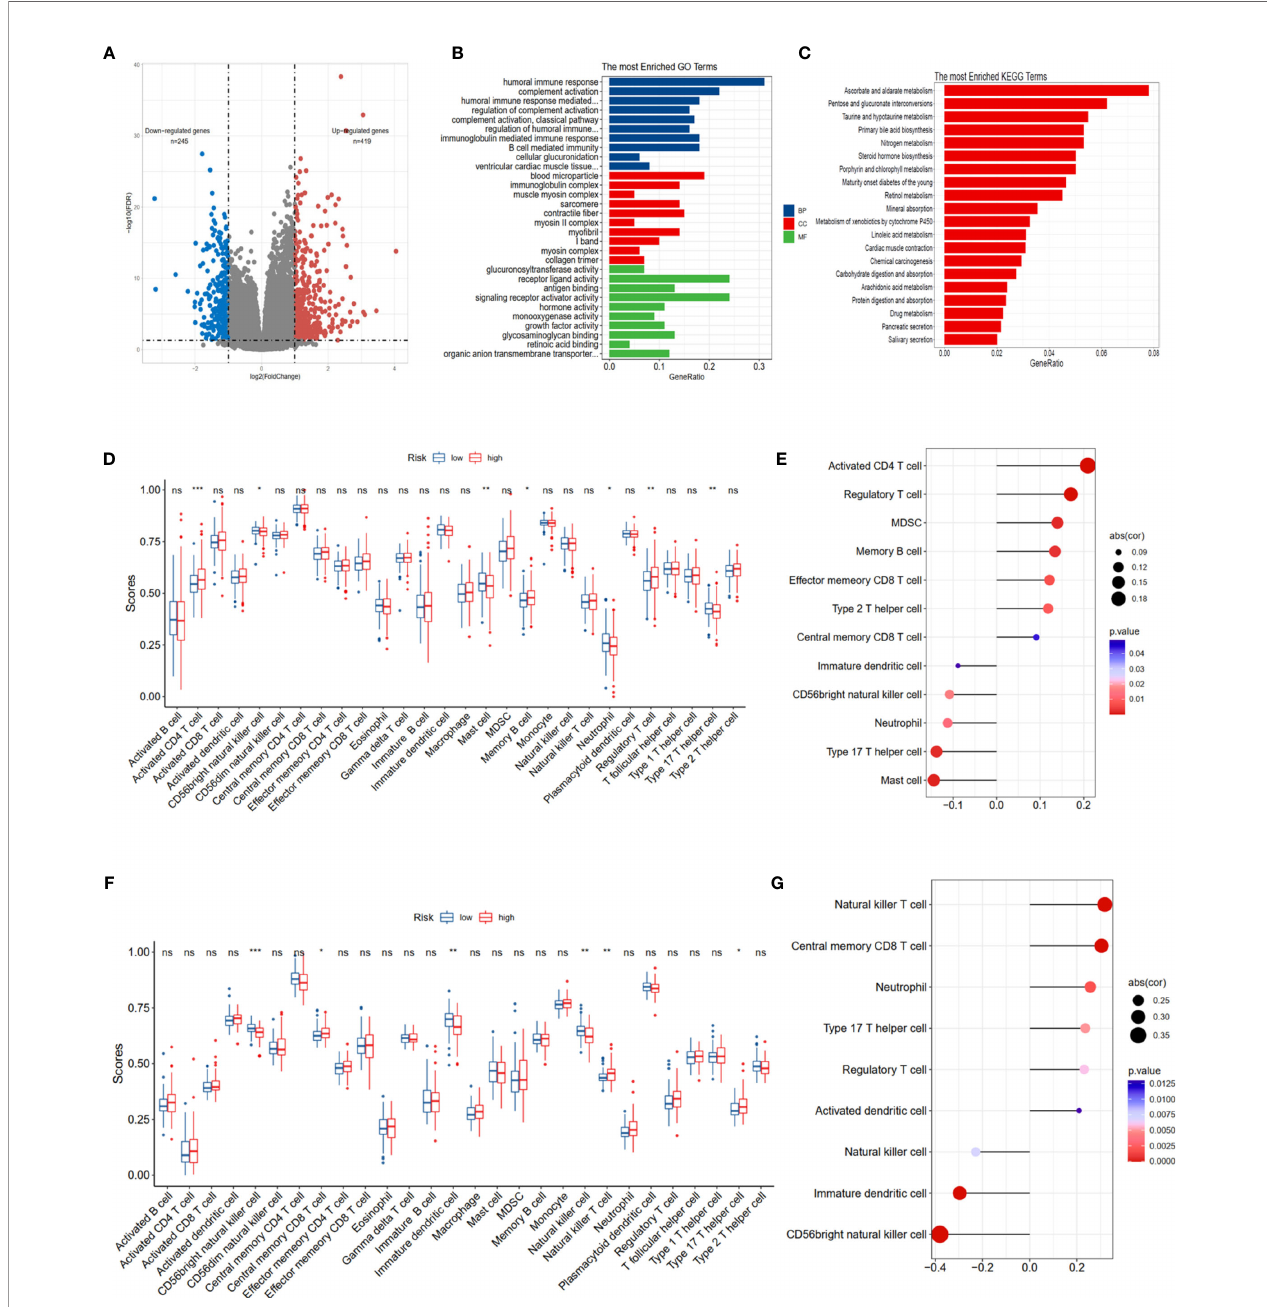
FIGURE 5 | Potential biological pathways affected by FRGs. (A) The different expression genes (DEGs) between the high-risk and low-risk groups. (B) The Gene Ontology (GO) enrichment of DEGs. (C) The KEGG enrichment of high and low risk groups. Comparison and correlations of the ssGSEA scores between different risk groups and risk scores in TCGA (D, E) and MSKCC (F, G) dataset. *P < 0.05, **P < 0.01, ***P < 0.001. ns, not signi fi